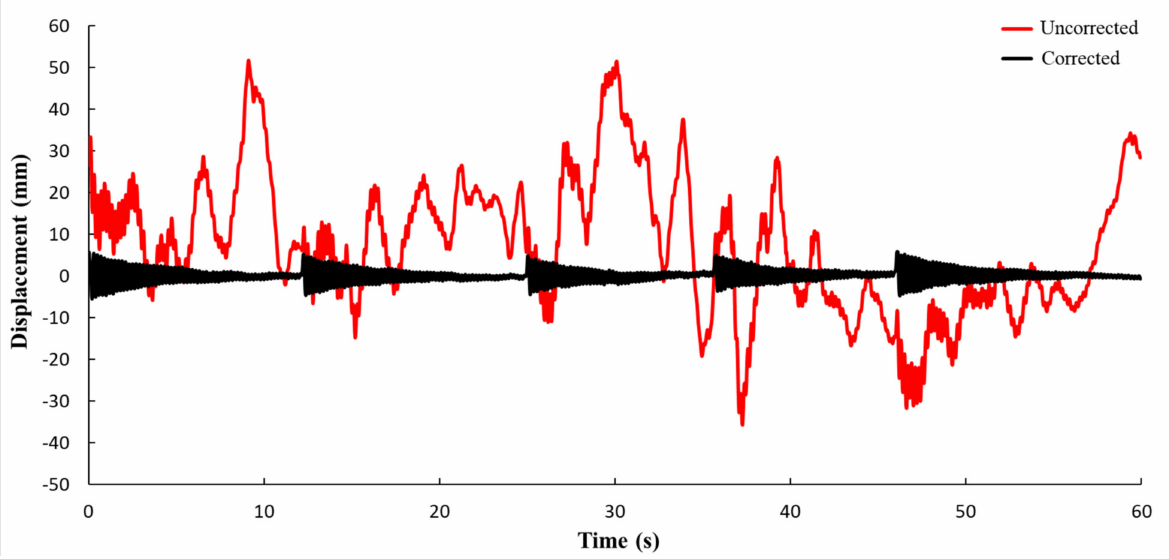
Figure 7. Comparison of displacement time history curves (corrected and